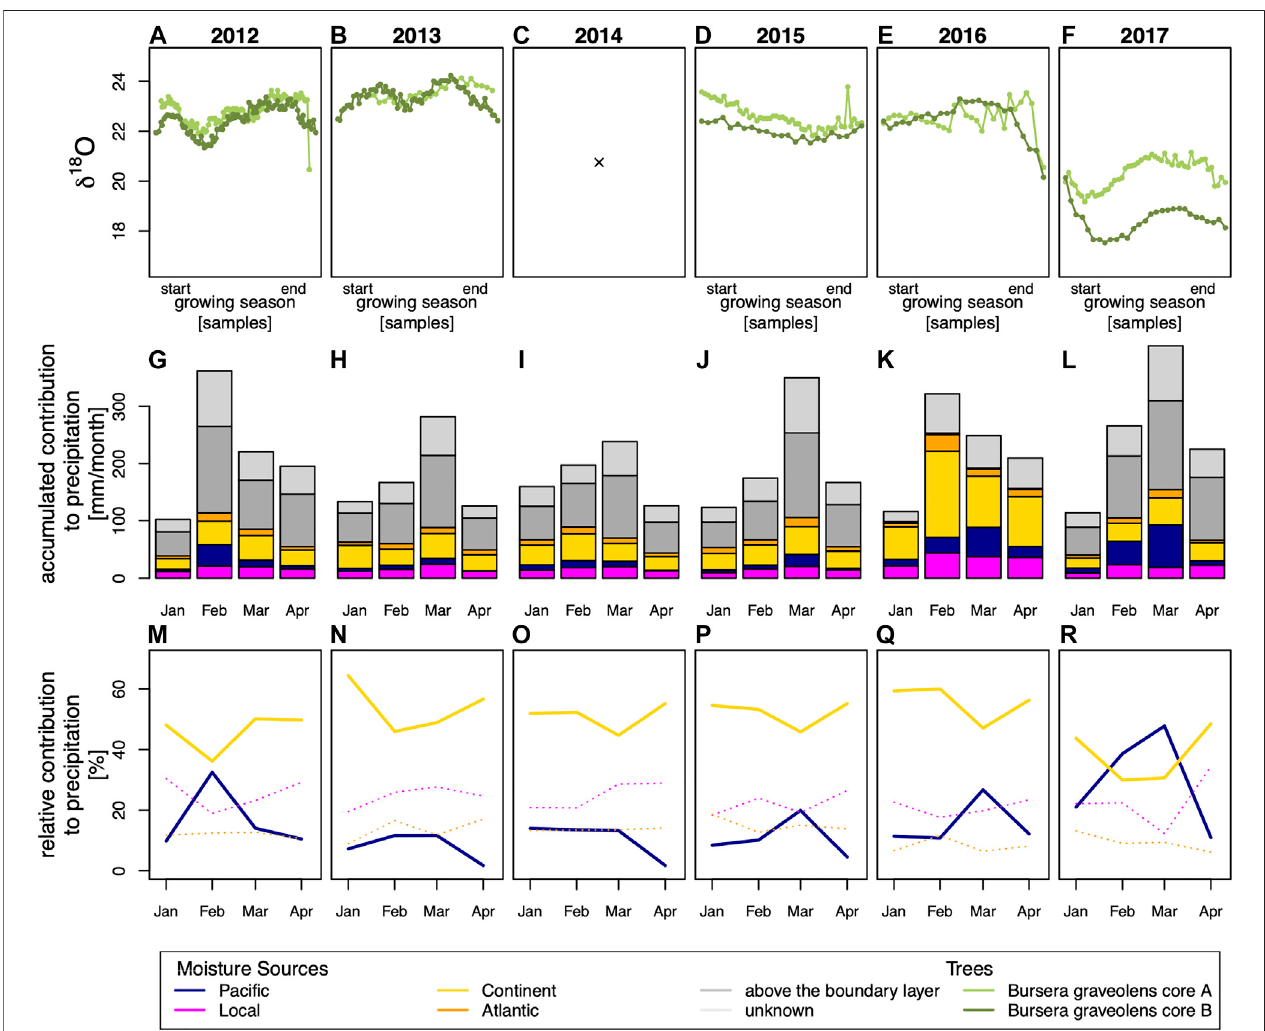
FIGURE 9 | Tree ring isotopes of Bursera graveolens for each year, the values are linearly distributed within the growing season, since a seasonal dating was not possible (A – F) .In2014,notreeringwasbuilt (C) .Accumulatedmoisturecontributionsfromdifferentregions (G – L) .Relativemoisturecontributionsfromdifferentregions (M – R) . Moisture contributions are based on the precipitation estimates derived from the trajectories.